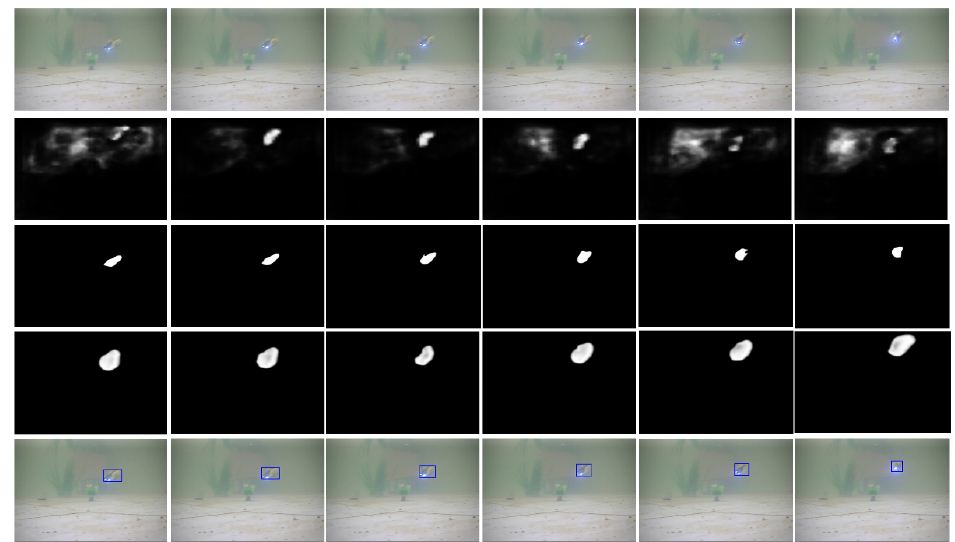
Figure 5. Results of Camera L saliency detection.